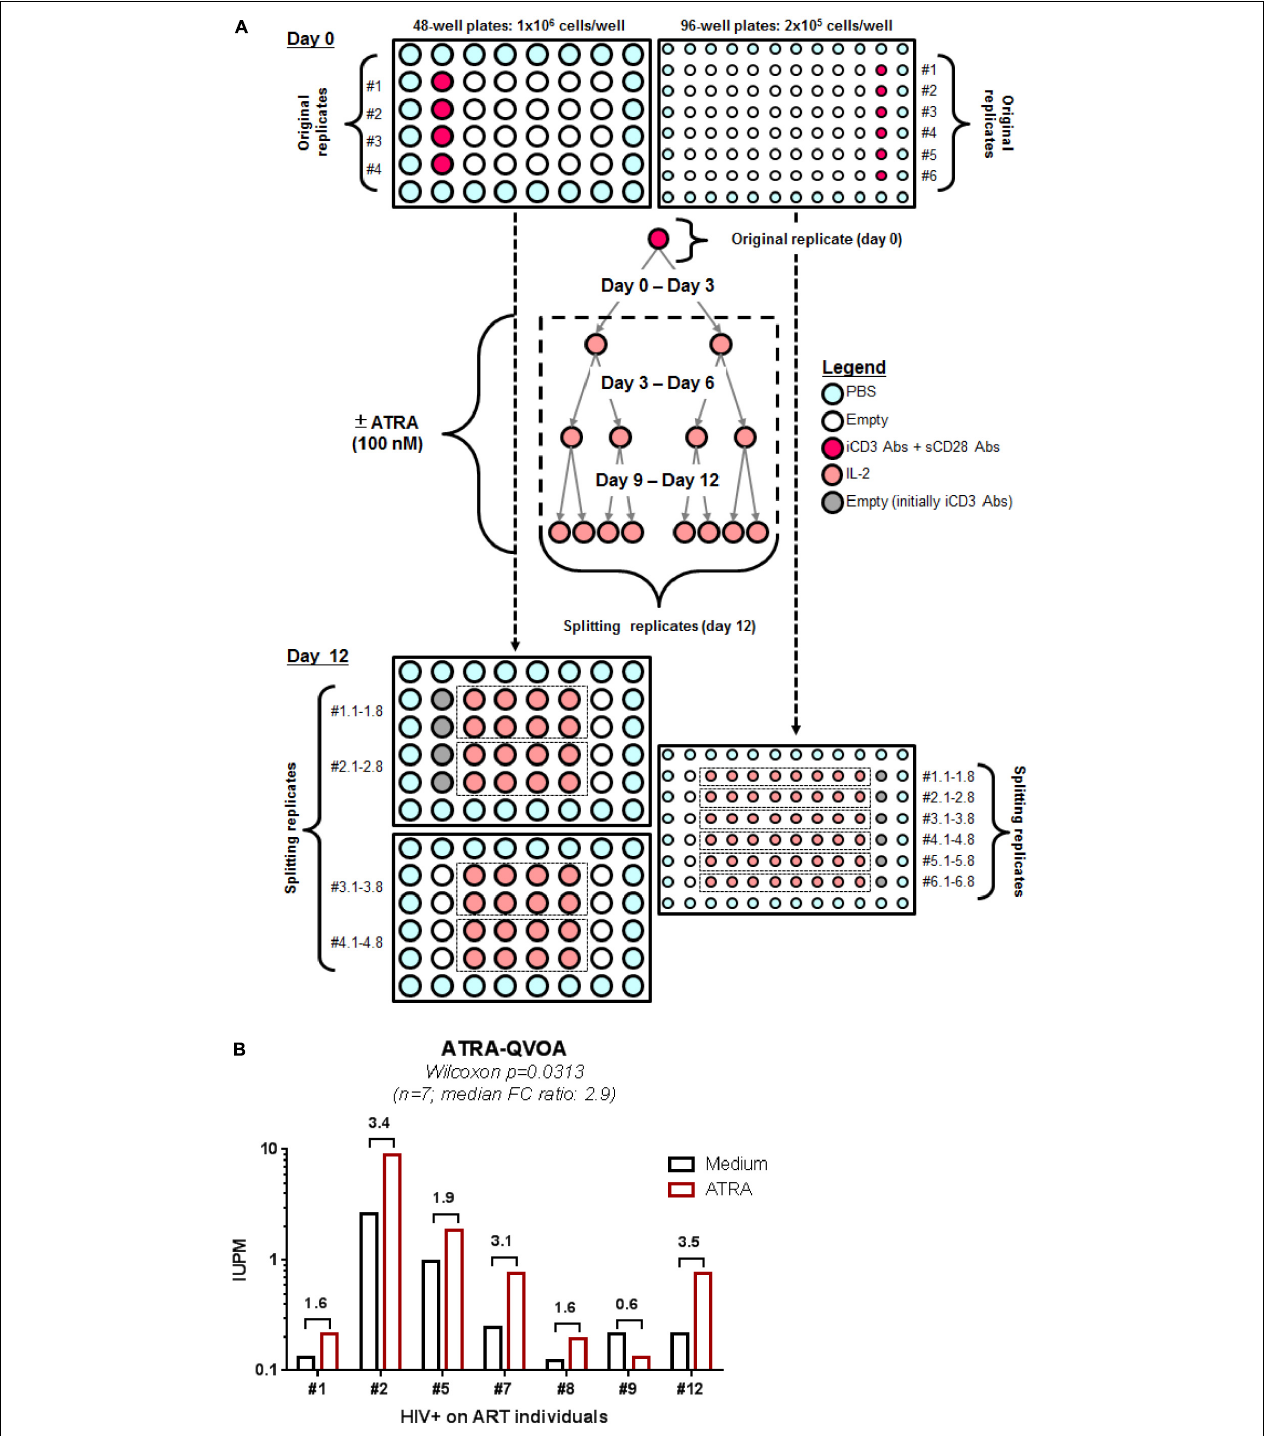
FIGURE 4 | A simplified ATRA-based QVOA. The VOP was performed as described in Figure 1A legend, illustrated in Supplementary Figure S5 , and described in section Materials and Methods using total memory CD4 + T-cells isolated from ART-treated PLWH. (A) Briefly, cells were cultured at two cell concentrations, 1 × 10 6 cells/well in 48-well plates (4 original replicates) and 2 × 10 5 cells/well in 96 well plates (6 original replicates) and stimulated via CD3/CD28 in the presence or absence of ATRA for 12 days. (B) Shown are the IUPM in cells from n = 7 HIV+ART PLWH ( Supplementary Table S1 ; HIV+ART #1, #2, #5, #7, #8, #9, #12), when the QVOA was performed in the presence and in the absence of ATRA. Fold changes in IUPMs observed in the presence of ATRA versus Medium for each donor cells is annotated on the graph. Wilcoxon matched-pairs signed rank test p -value is indicated on the graph.